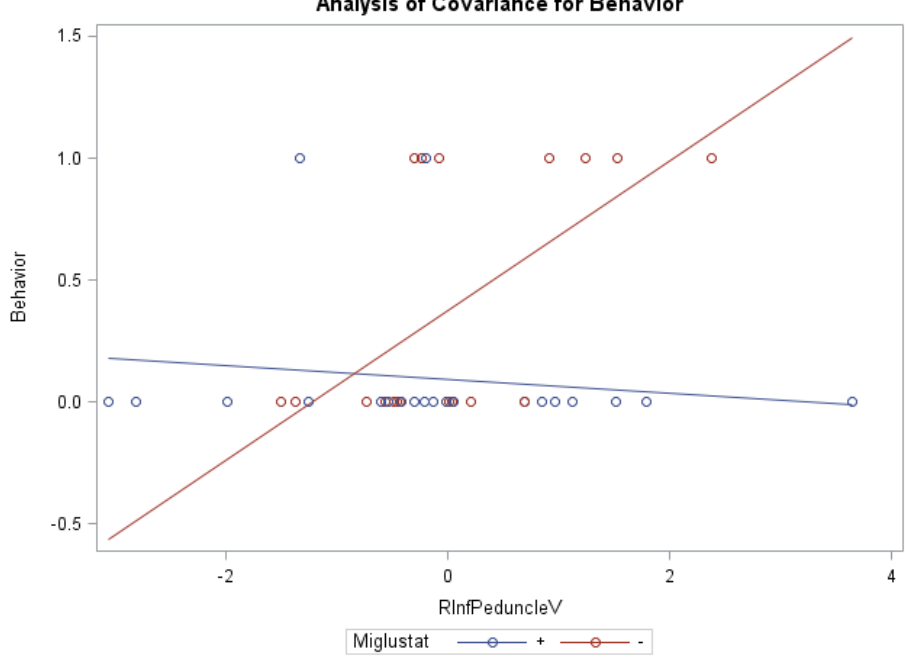
Figure 2. ANCOVA of behavior, miglustat, and volume of r inferior peduncle.